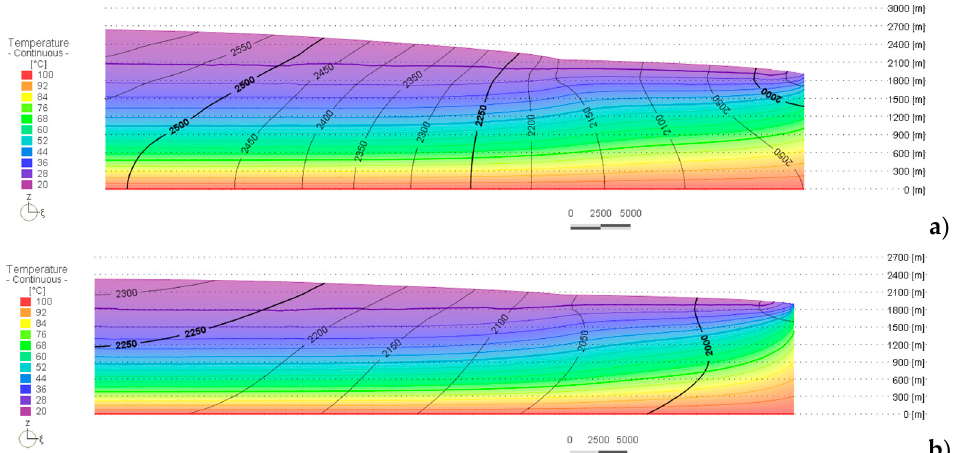
Figure 9. Cross-sections of W-Laja. Distribution of temperature and equipotential lines for: ( a ) sce- nario II (convective 1); and ( b ) scenario III (convective 2) (Table 1).